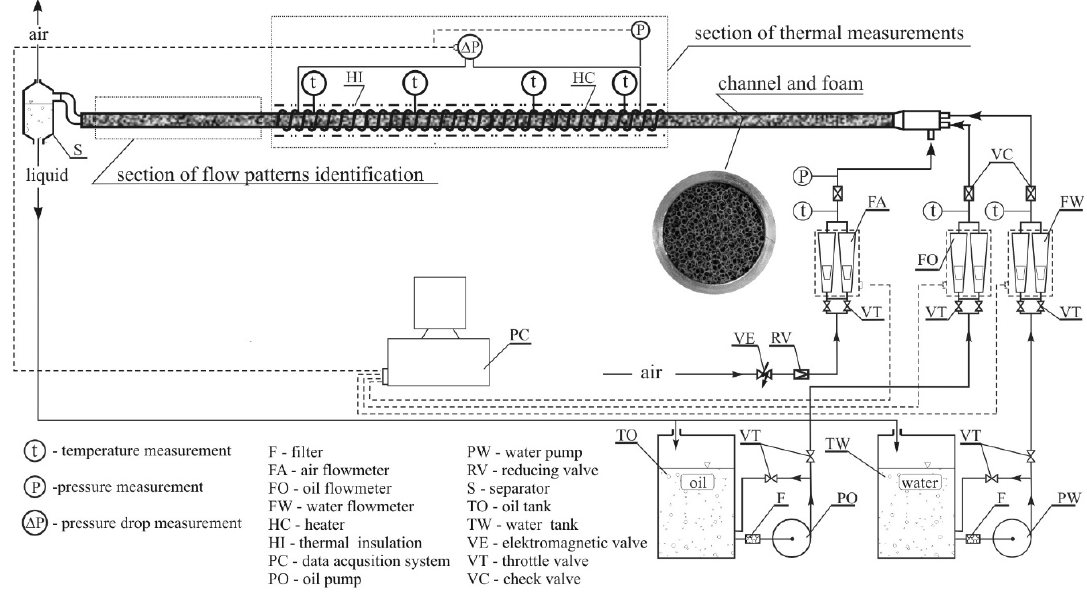
Figure 2. Experimental setup.